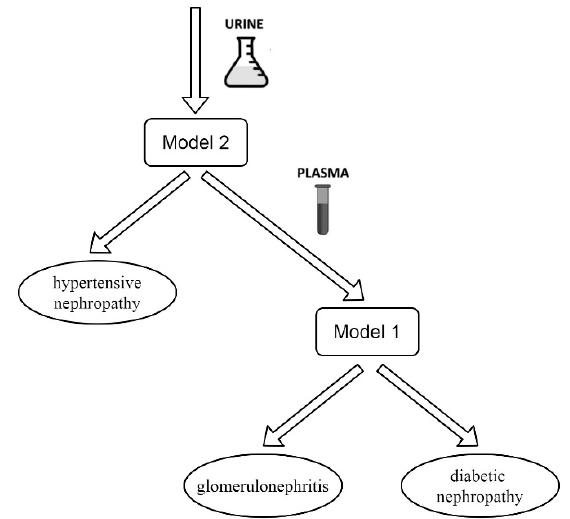
Figure 2. Scheme of two-stage differential diagnosis of chronic kidney disease using proteomic data of urine and plasma.